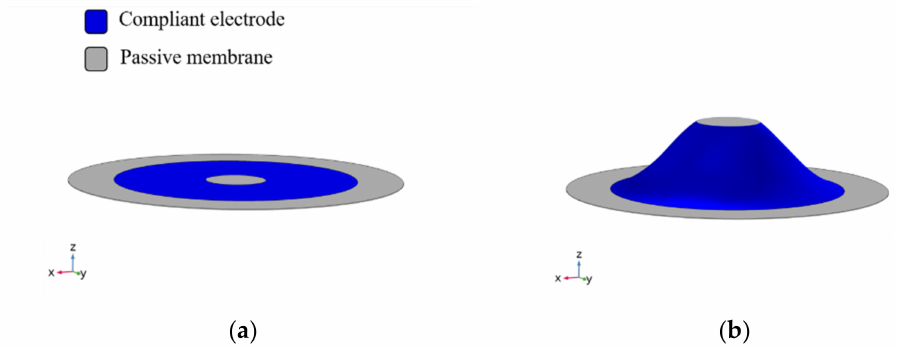
Figure 3. Three-dimensional (3D) rendering of a DEA: ( a ) undeformed flat configuration; ( b ) de- formed out-of-the plane